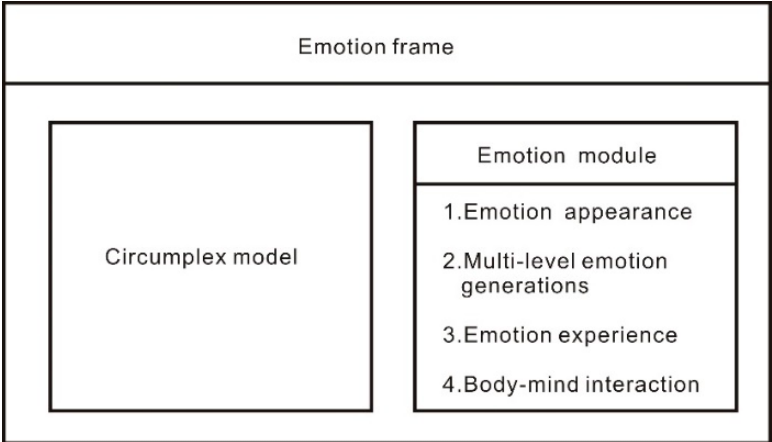
Figure 1. Emotional framework of the designed system.